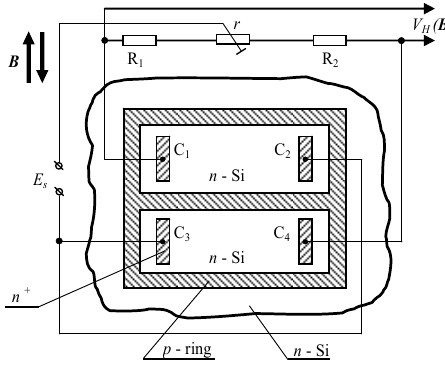
Figure 1. Schematic top-view of two identical n -Si 2C magnetoresistors on the same chip forming in-plane sensitive Hall device. The original coupling transforms the magnetoresistors into a symmetrical 4C Hall